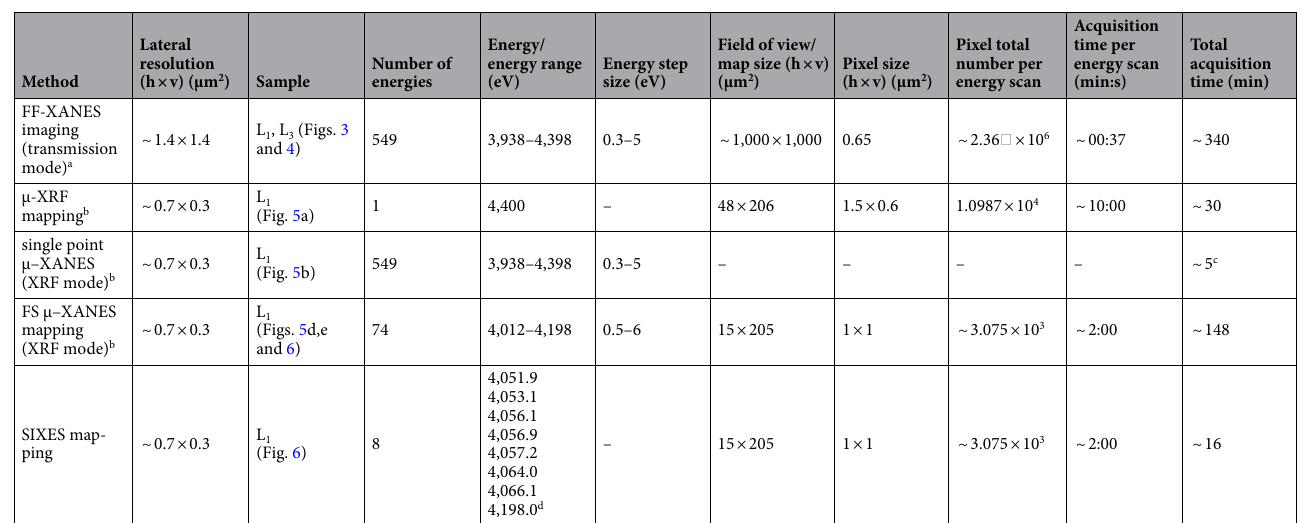
Figure 6. Comparison between the normalized distribution maps of different Ca-based phases obtained by LSLC fit of: (left) FS μ-XANES stack (n. 74 energies) (cf. Fig. 5d,e) and (right) SIXES stack (n. 8 energies) (see Supplementary Information, Figs. S2 and S4, for further details).